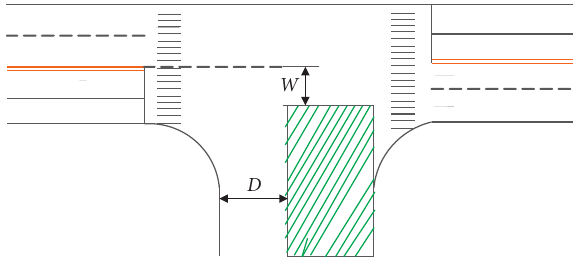
Figure 9: The three-leg intersection with a straddling work